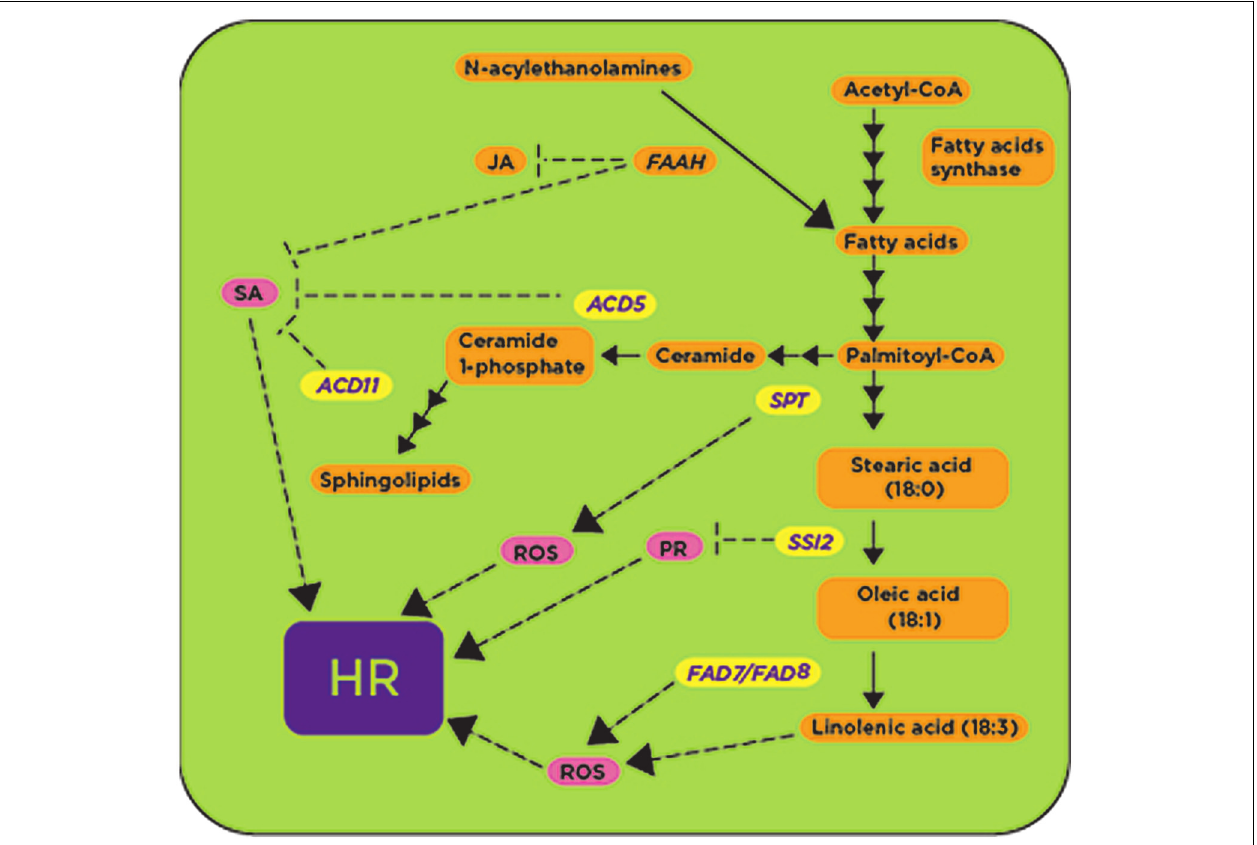
FIGURE 4 | Metabolic enzymes involved in fatty acid and sphingolipids biosynthetic pathways are involved in defense responses. Some genes required for fatty acid and sphingolipid biosynthesis have been shown to be upregulated (shown in yellow) in the presence of avirulent pathogens and pathogen-derived elicitors.The activities of ACD5 , ACD11 , and SSI2 are proposed to play a negative role (shown with blunt-ended lines)